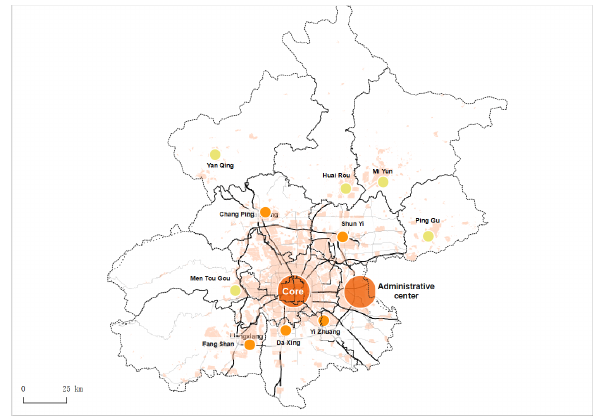
Figure 1. The concept plan of